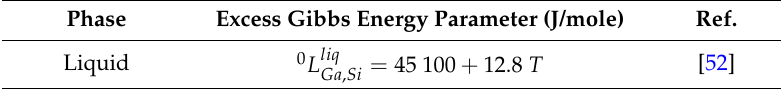
Figure 23. ( a ) Enthalpy of mixing of In-Si melts at 1427 °C [52]; -·-·-: [121]; ····: [120]; -----: [66] at 1427 °C and ( b ) Activity of In and Si in the liquid In-Si phase [124,210]; -----: [67] at 1427 °C. Table 11. Model parameters of the In-Si system. Phase Excess Gibbs Energy parameter (J/mole) Ref.